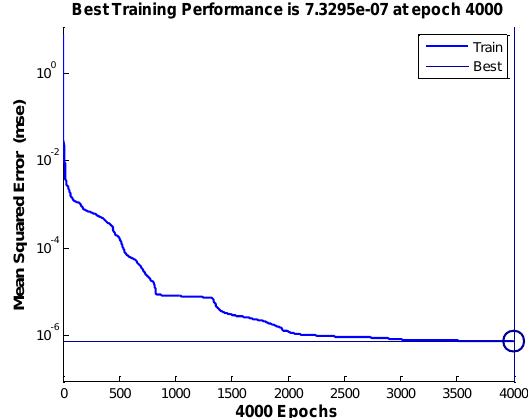
Figure 8. Performance of the ANN- BPSO optimization.